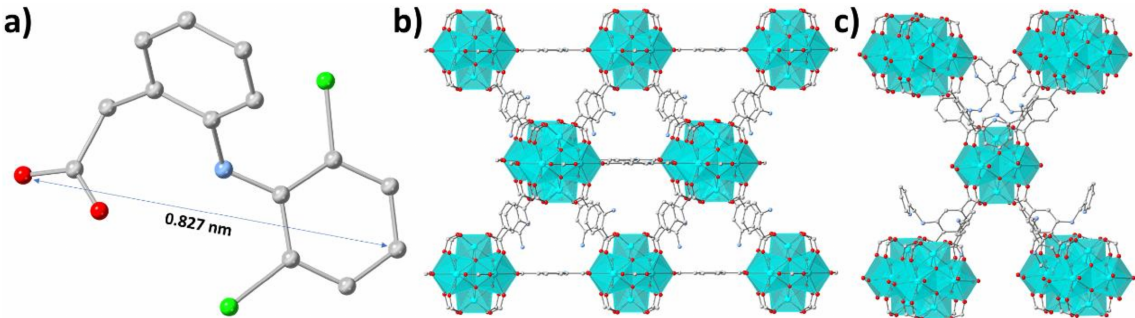
Figure 1. Representation of the structures of ( a ) diclofenac sodium salt, ( b ) MOR-1 and ( c ) MOR-2 . Color code: C, grey; Cl, green; O, red; N, blue; Zr,